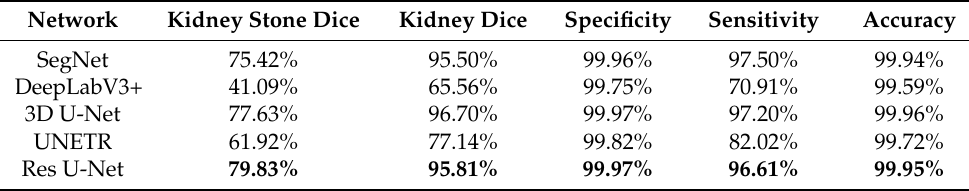
Table 2. The performances of the networks trained